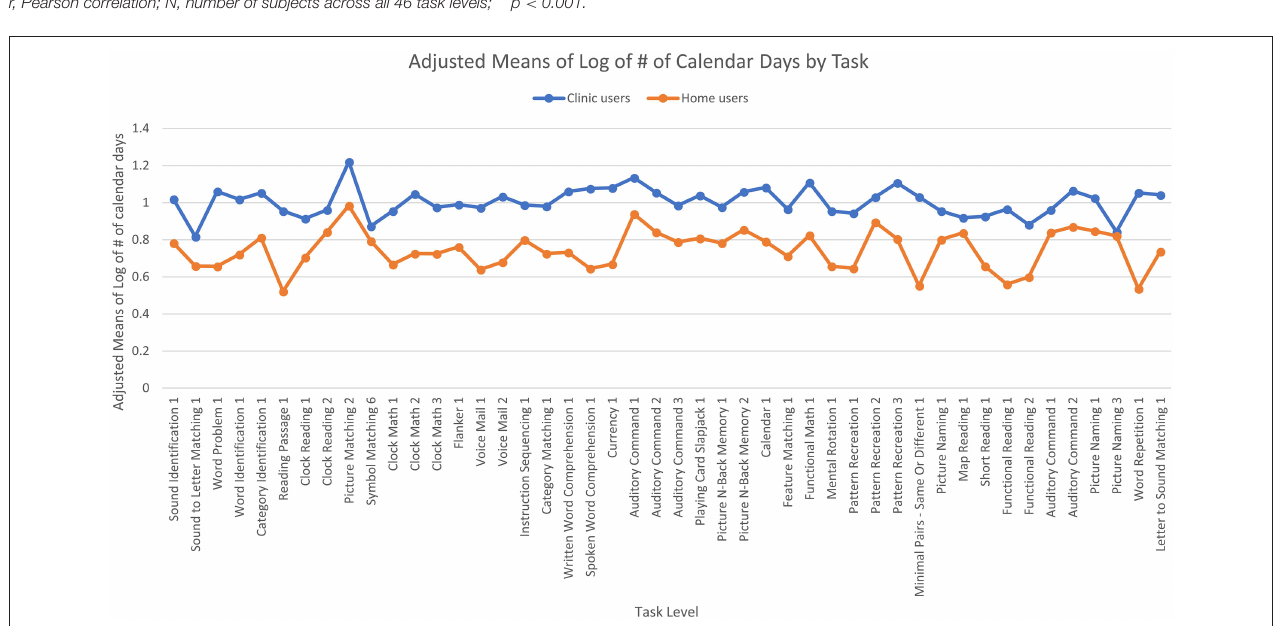
FIGURE 2 | Adjusted means for the number of calendar days passed by user group. Covariates appearing in the model are evaluated at the following values: years since injury = 2.10, age = 61.62. where clinic users required more days of therapy than home users for some task levels but the opposite was true for other task